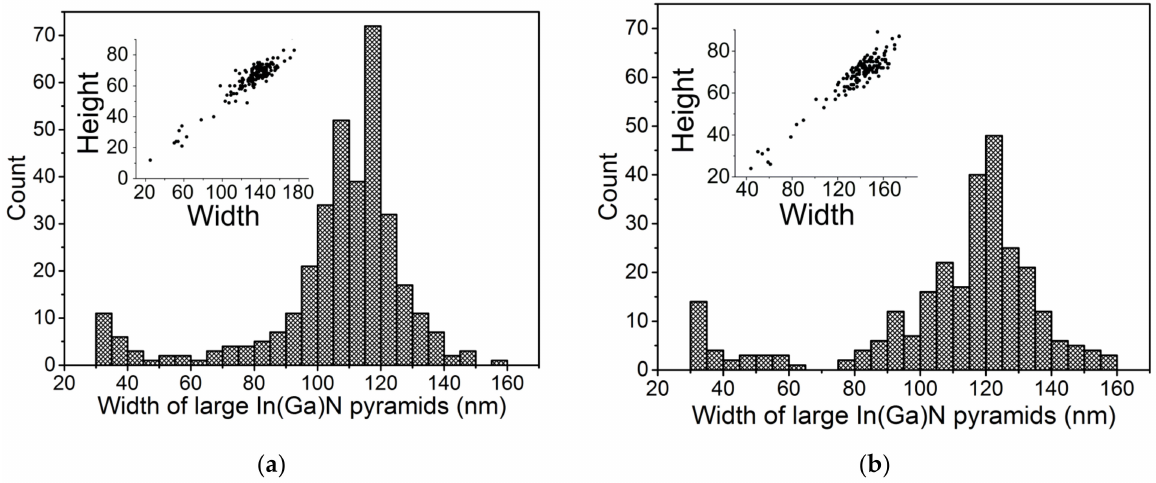
Figure 3. In(Ga)N pyramid width distribution on on-axis ( a ) and off-axis ( b ) samples. Insets show the correlation of their width and